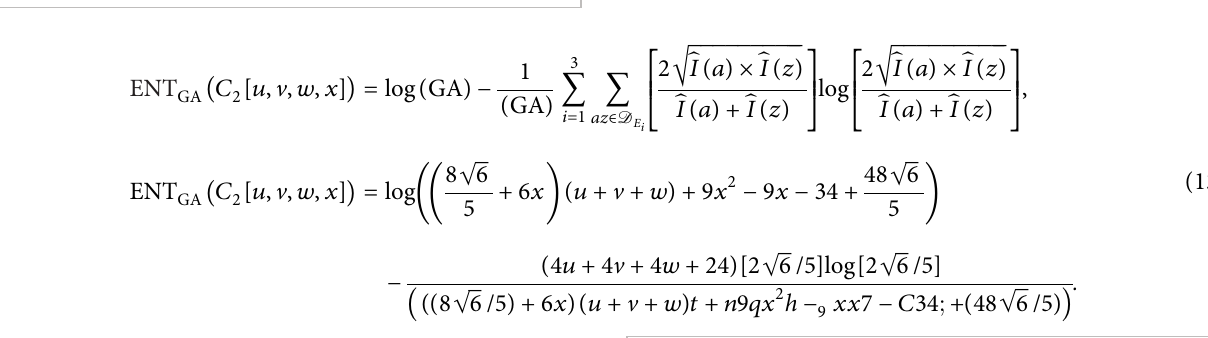
Table 5: Comparison of ENT